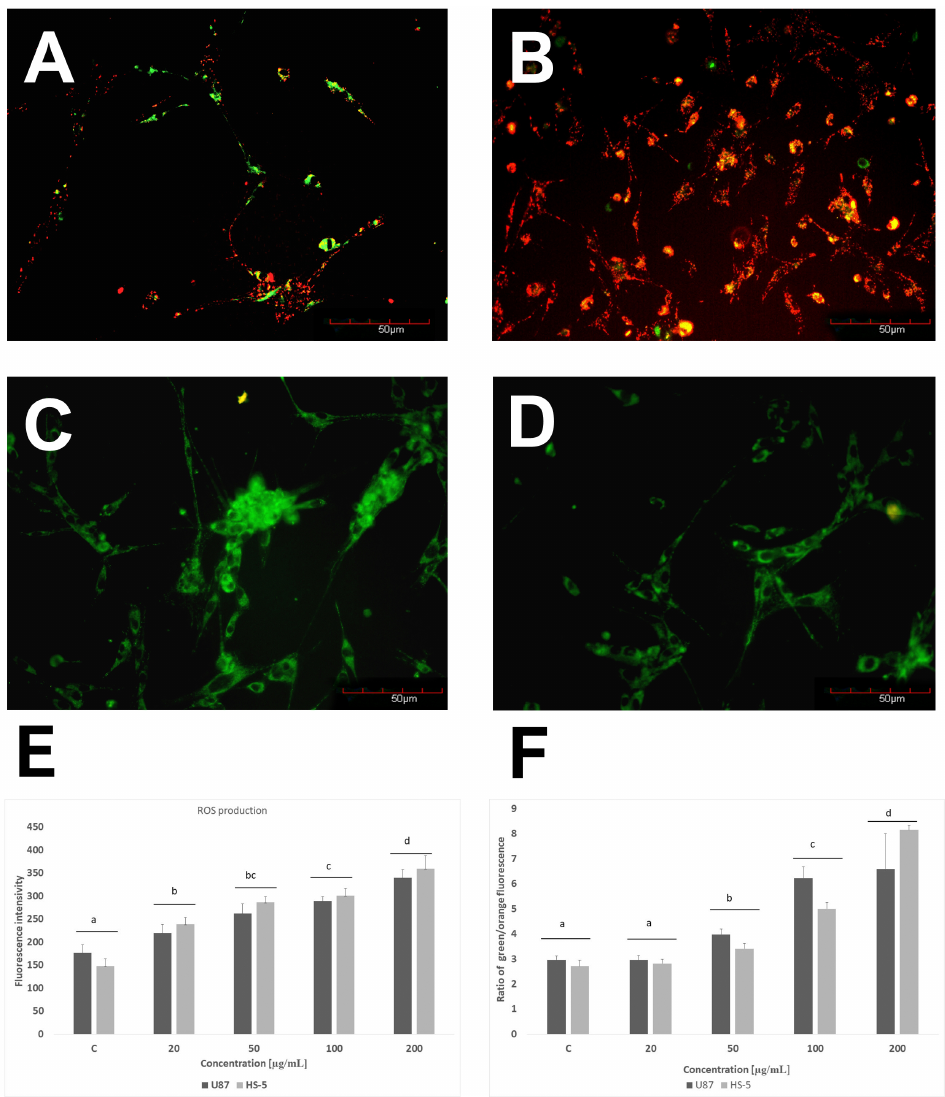
( B , D ) and ROS production ( E ). A , B –control cells, C , D –cells exposed to 50 µ g/mL of GPs. F –ratio Figure 5. Investigation of mitochondrial transmembrane potential of U87 ( A , C ) and HS-5 cells ( B , D ) of green/orange and ROS production ( E ). A , B –control cells, C , D –cells exposed to 50 μg/mL of GPs. F –ratio of green/orange fluorescence.